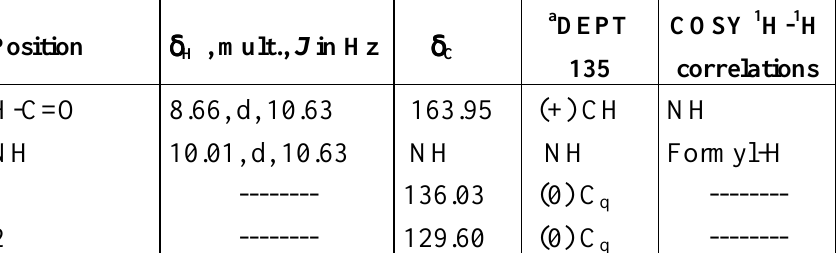
Table 2 . 1 H(400 MHz) and 13 C-NMR (100MHz) Spectral Data for trans - 2 in DMSO- d